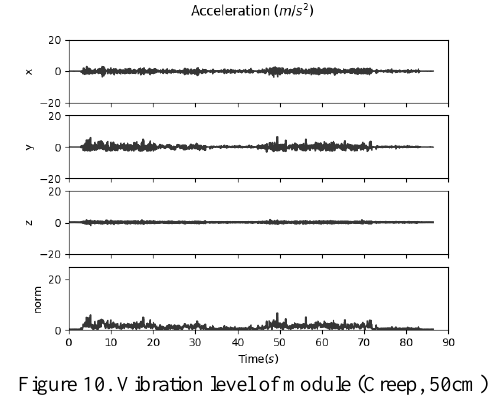
Figure 6. Vibration level of module (Creep, 15cm)